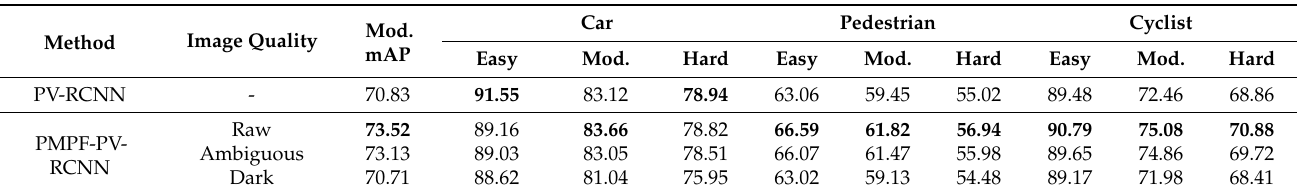
Table 5. Quantitative comparison between PMPF under different image quality scenarios and PV-RCNN on KITTI 3D object detection validation.